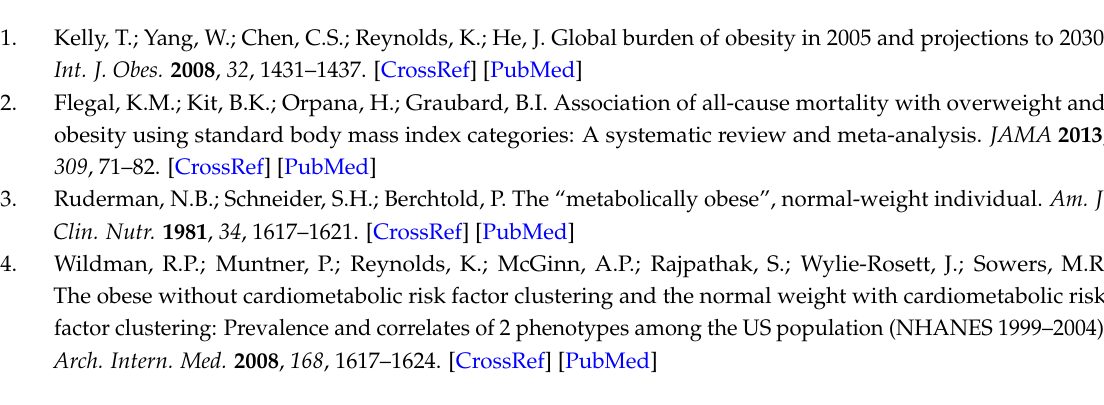
Figure S1: Funnel plot of standard error by standard differences in means of (a) Body Mass Index; (b) Systolic Blood Pressure; (c) Diastolic Blood Pressure; (d) Tryglicerides; (e) HDL-cholesterol; (f) Fasting Glucose; (g) HOMA-OR; (h)